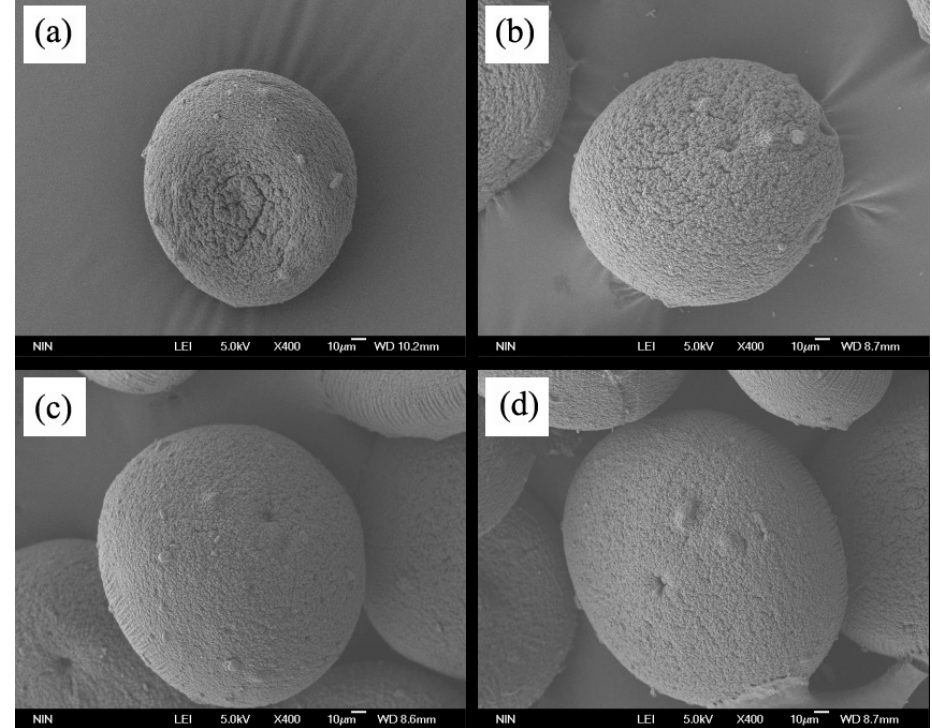
Figure 2. Scanning electron micrograph of microparticles. ( a ) Empty CS/ALG; ( b ) CS/ALG-(PHLC-Ca) (ALG:PHLC-Ca1:1/3); ( c ) CS/ALG-(PHLC-Ca)(ALG:PHLC-Ca1:1/2); ( d ) CS/ALG-(PHLC-Ca) (ALG:PHLC-Ca 1:1).